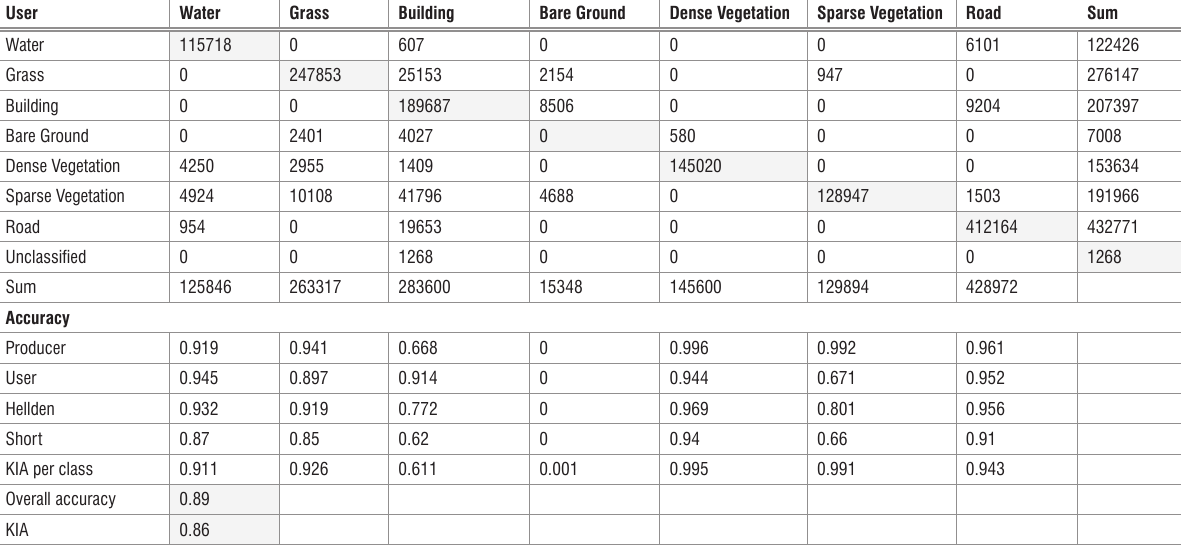
Table 1: Error matrix based on training and test areas mask using Haralick textural features